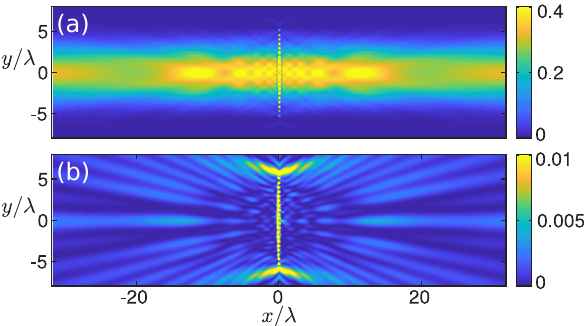
Figure 5: Spatial dependence of intensity for reflecting and CPA phasesfora20 × 20atomarrayonthe yz planeat x =0.Totaloutgoing coherent intensity for ˜ δ (cid:1) 0, (a) δ (cid:1) 0, where | t + r | 2 (cid:1) 0 . 6, and (b) δ (cid:1) 0 . 4, where | t + r | 2 (cid:1) 0 . 03, showing CPA, when the atoms are illuminated by Gaussian beams propagating from ± x directions. Note different color scales. Field is normalized such that | E | (cid:1) 1 at x = 0. form as Equation (14), with υ being replaced by υ ′ P , and diverges at the EP.